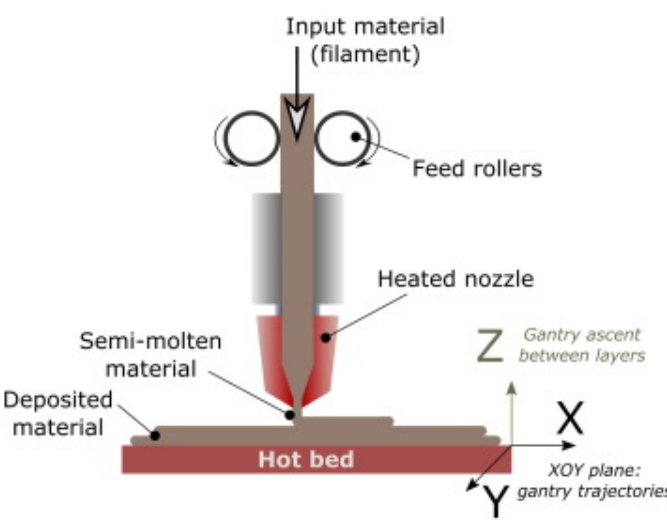
Figure 1. Fused filament fabrication (FFF) process (reproduced with permission from [1]).